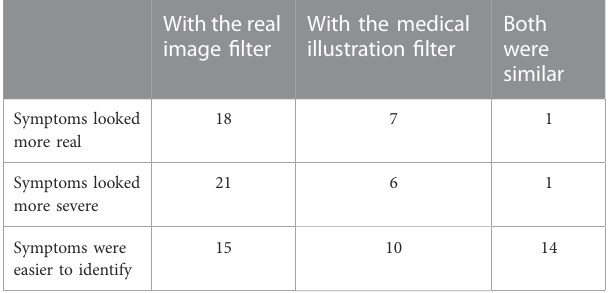
TABLE 7 Summary of fi lter fi delity qualitative results. The numbers in the table represent the count of participants who indicated a particular perception. Not allresponseswererelevanttothequestionssothecountsdonotadduptothe total number of responses. With the real image fi lter